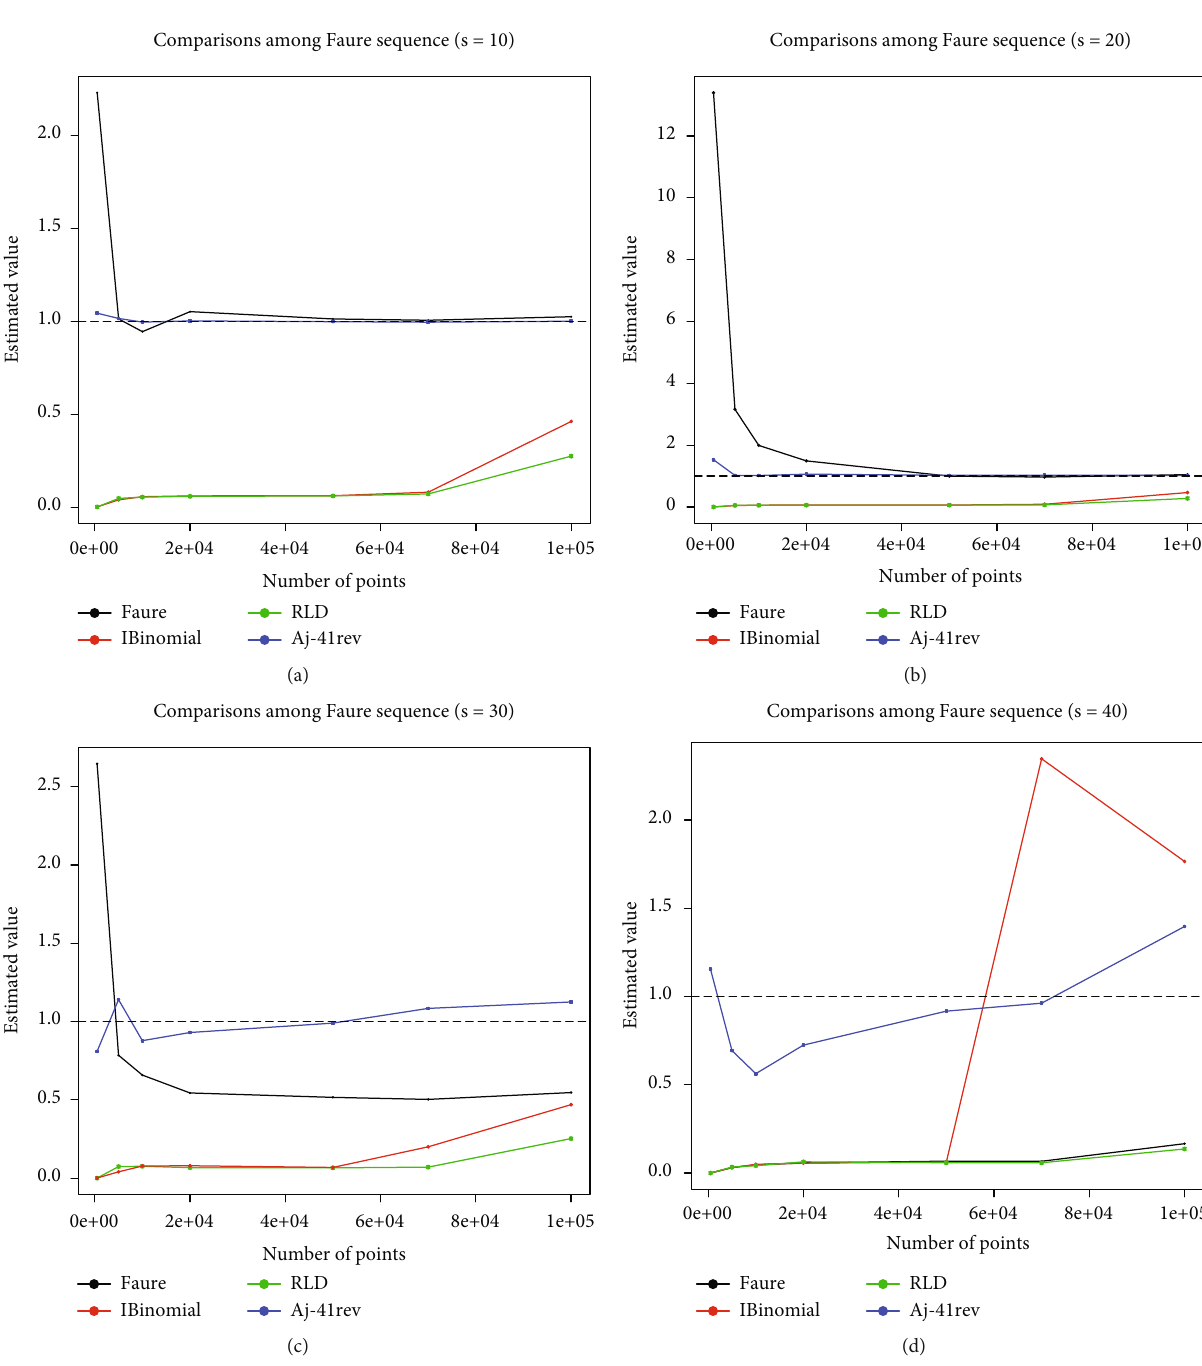
ð f Þ by using various Faure 1